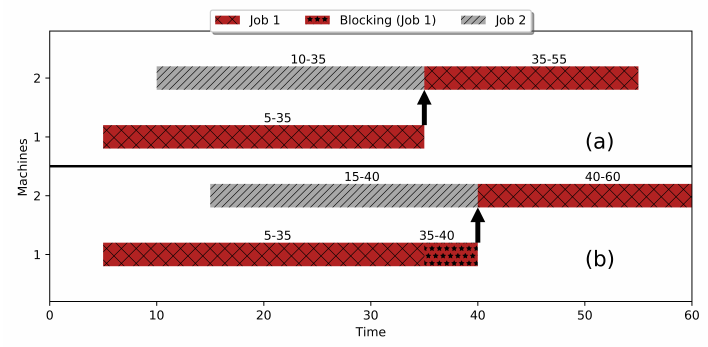
Figure 1. Blocking conditions in job-shop